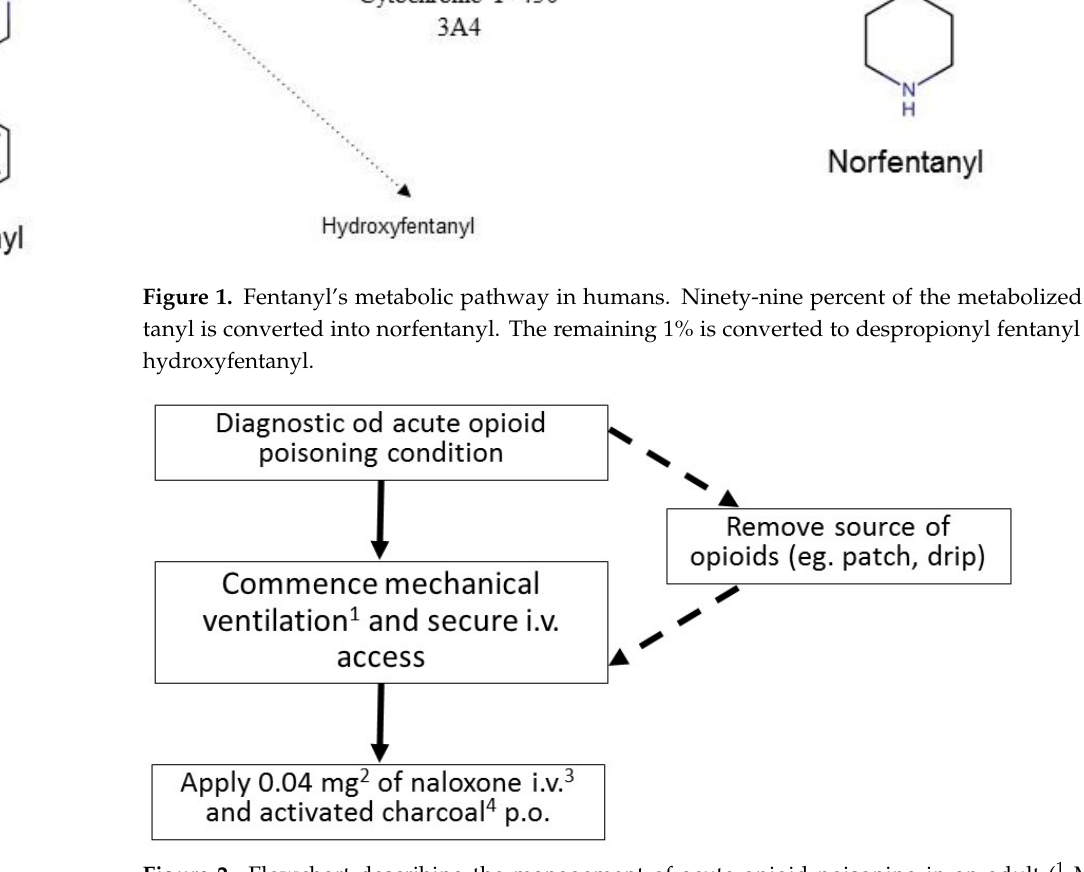
Figure 1. Fentanyl’s metabolic pathway in humans. Ninety-nine percent of the metabolized fentanyl is converted into norfentanyl. The remaining 1% is converted to despropionyl fentanyl and hydroxyfentanyl.